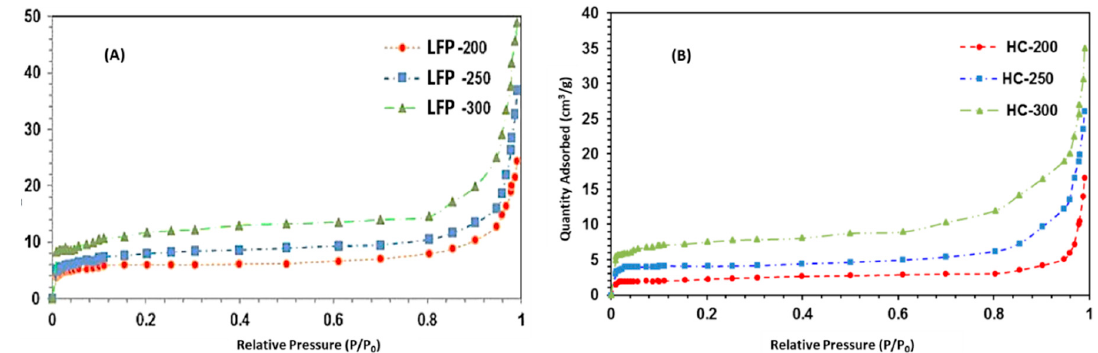
Figure 5. BET Isotherms of ( A ) LFP-200, LFP-250, and LFP-300. ( B ) HC-200, HC-250, and HC-300. The textural parameters determined for both starting materials with corresponding carbon micro-spheres are listed in Table 3. Table 3. Pore characteristics of Dimocarpus longan peel powder (LFP) and Holocellulose (HC) with carbonized samples resulting from hydrothermal treatment (HTC) at different temperatures. Sample BET Surface Area (m 2